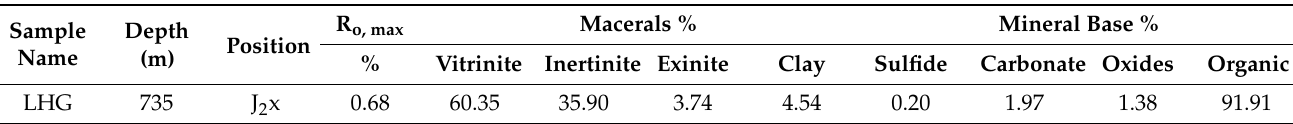
Table 1. Test results of low-rank coal samples.